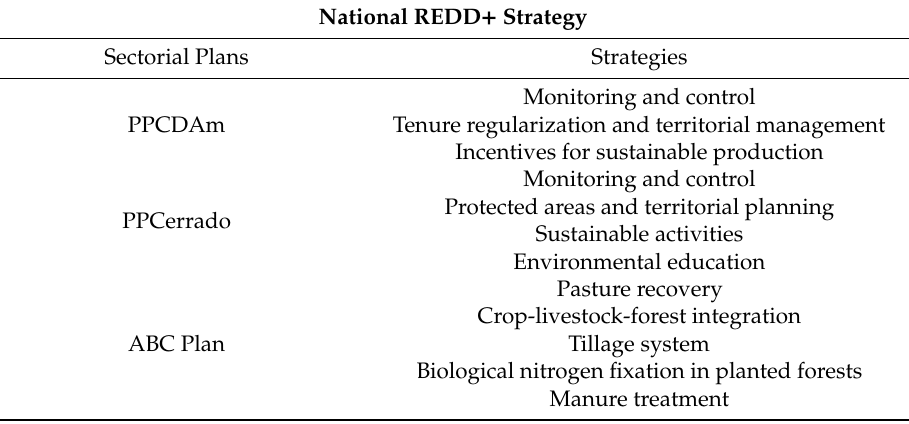
Table 1. Plans guiding Brazil’s National Reducing Emissions from Deforestation and Forest Degradation (REDD + )